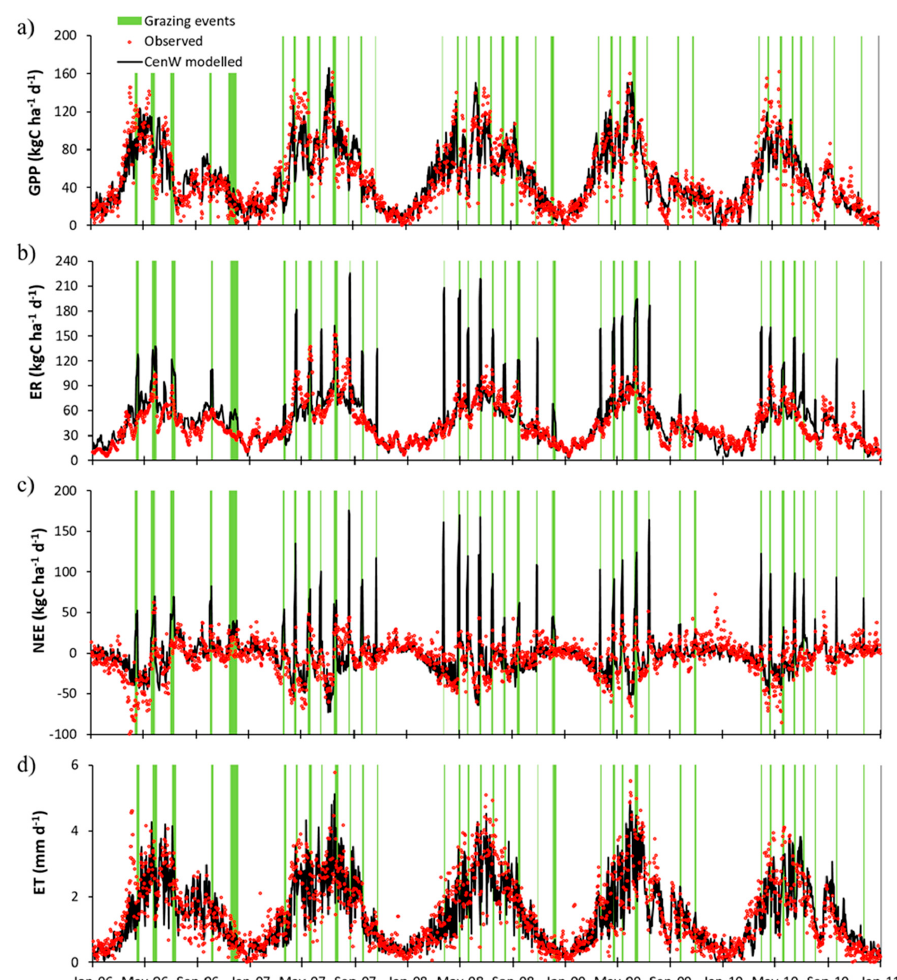
Figure 7. Time series of modeled (black line) and observed (red dots) daily carbon fluxes and water fluxes ( a ) GPP, ( b ) ER, ( c ) NEE, and ( d ) ET for the grazed grassland site. Vertical green lines represent grazing events.